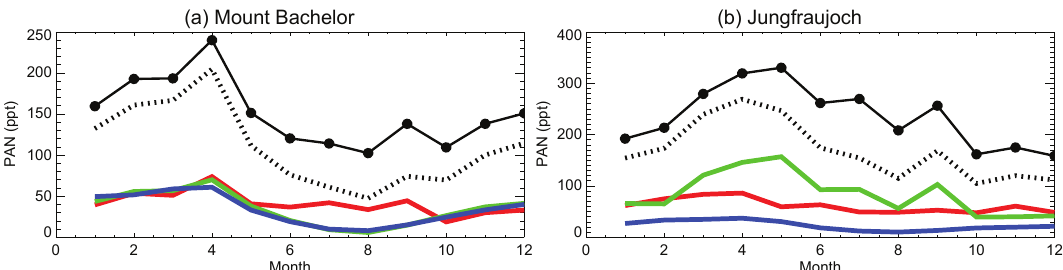
Figure 1. Multi-model monthly mean total PAN mixing ratios (black circles and solid lines) at Mount Bachelor (a) and Jungfraujoch (b) . We take the difference between the base simulation (SR1) and one in which emissions are decreased by 20% and then multiply the difference by 5 to estimate a 100% contribution associated with anthropogenic precursor emissions from Europe (green), North America (red), and East Asia (blue). The sum of the anthropogenic contribution from these three regions is shown (dashed black) for comparison with total simulated PAN.